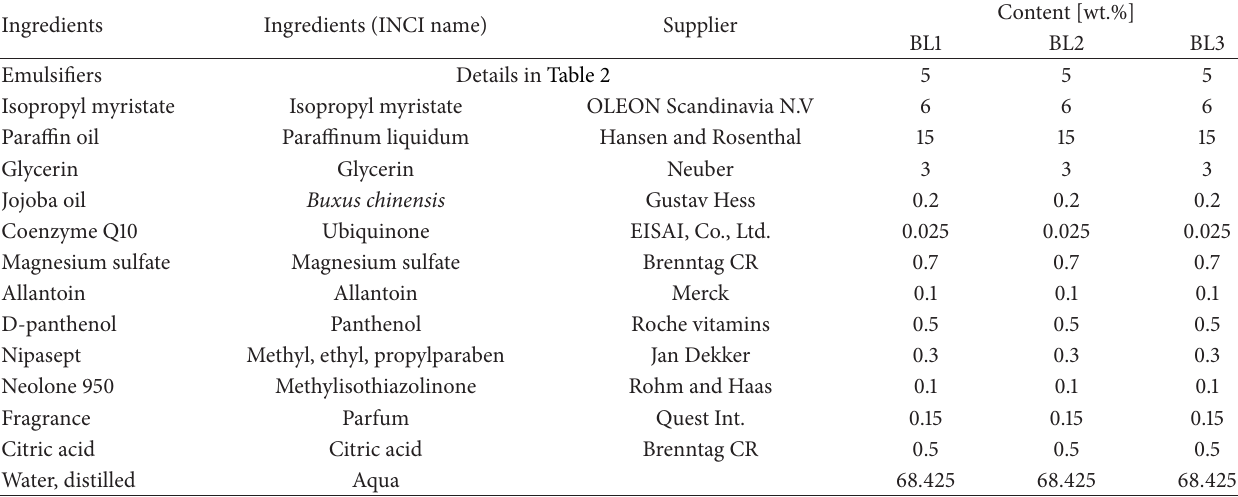
Table 1: Ingredients of the samples.